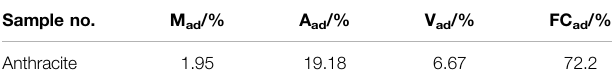
TABLE 1 | The data of industrial analysis of the coal sample. Sample